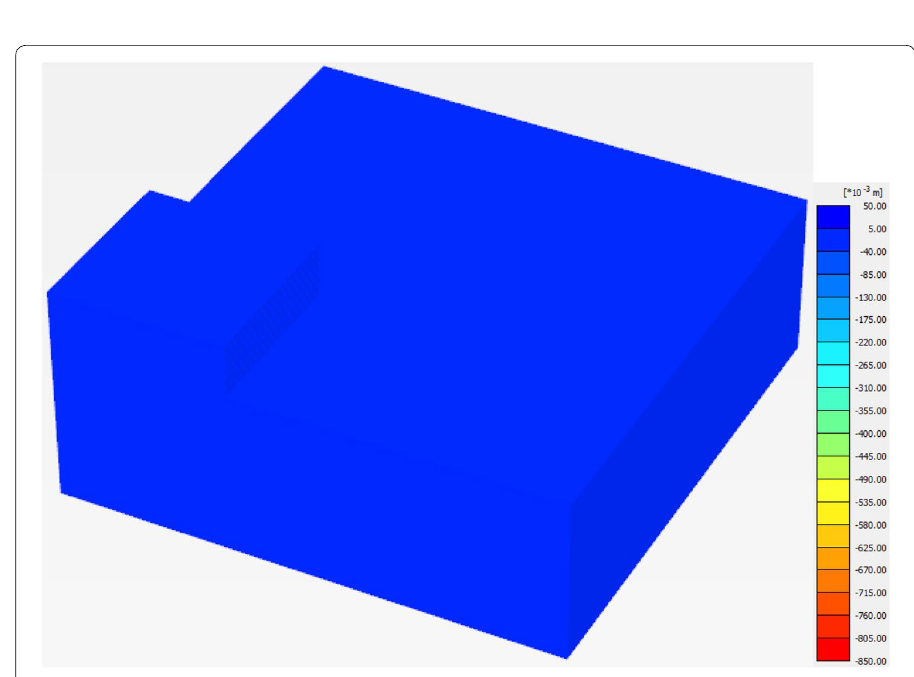
Fig. 22 Vertical displacement contour of Case